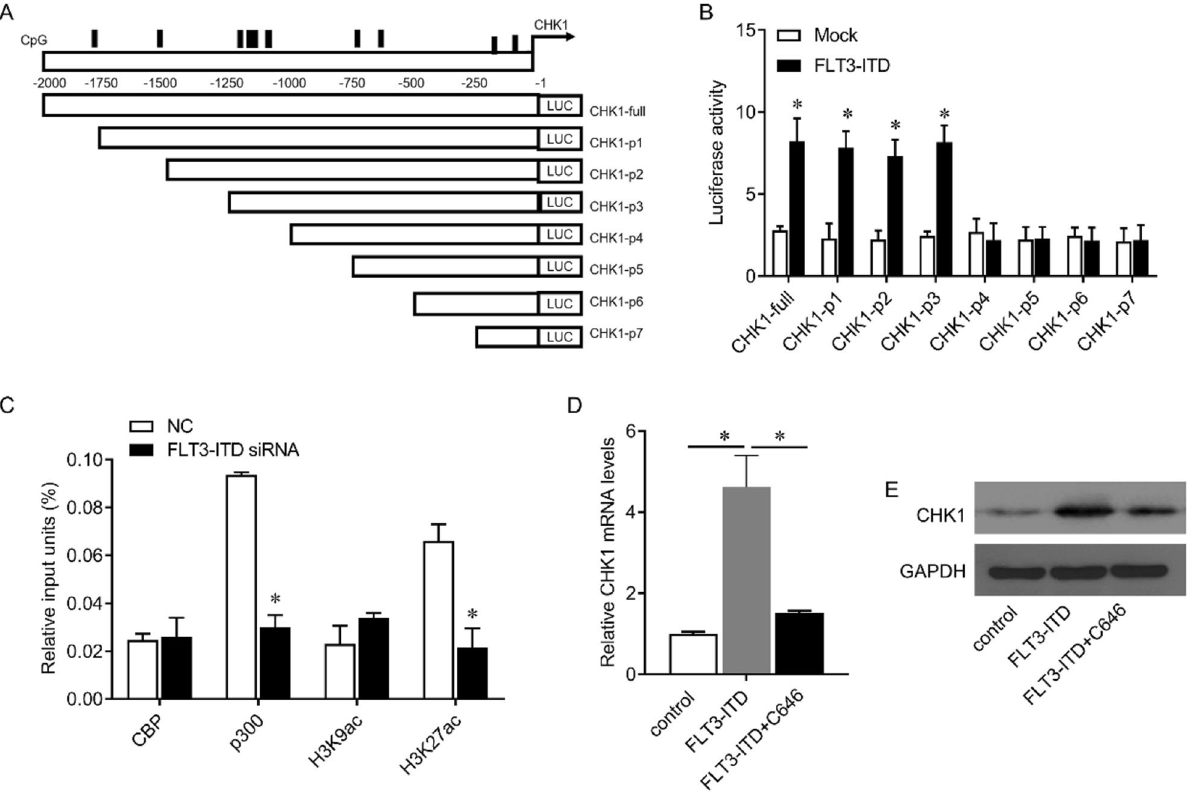
Figure 3. FLT3-ITD epigenetically activates CHK1. ( A ) Schematic representation of the CpG island of the CHK1 promoter. Vertical lines indicate CpG islands (upper panel). Schematic diagram of the construction of the luciferase reporter vector for the full-length fragment of the CHK promoter and its truncated fragment (every 250 bases). The numbers indicate the nucleotide position relative to CHK1 (+ 1 nt) (low panel). ( B ) 293 T cells were co-transfected with CHK1 promoter luciferase reporter vector and FLT3-ITD expression vector for 48 h, the luciferase reporter activity was detected. ( C ) After transfection of FLT3-ITD siRNA in MV4-11 cells, ChIP was performed using the designated antibody or IgG, and qRT-PCR was performed to detect the enrichment of protein on the CHK1 promoter. ( D , E ) Kasumi-1 cells were transfected with FLT3-ITD expression vector and treated with C646 (30 nM) for 24 h. qRT-PCR ( D ) and Western blot ( E ) were used to detect the expression of CHK1 mRNA and protein. The original blots were presented in Supplementary Fig. 1. The expression value is shown as the mean ± SEM. *p <